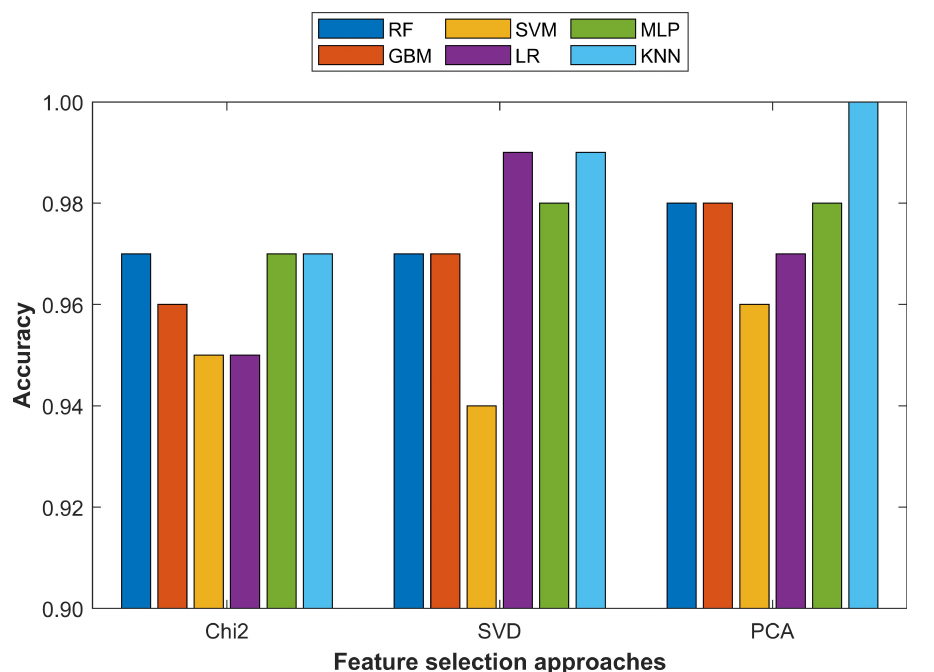
Figure 5. Comparison of different machine learning models with 15 selected features from Chi2, SVD, and PCA approaches.